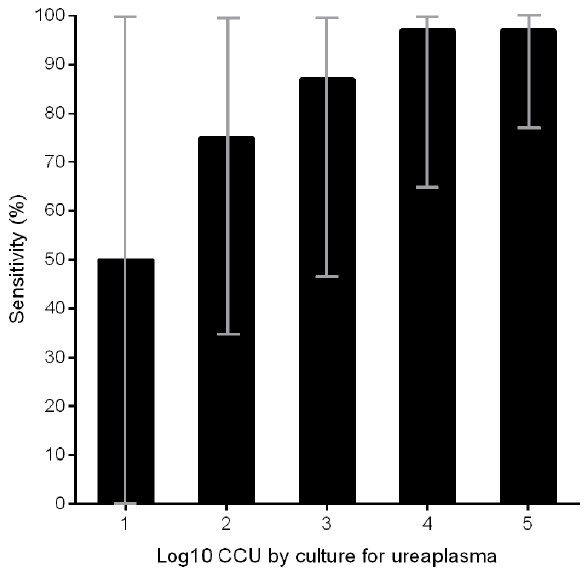
Figure 2. Bar-chart showing sensitivity in CCU group 1–5 for all sample types, male and female samples combined. CCU 1–5: 1 positive of 2 (50%), 9 of 12 (75%), 13 of 15 (87%), 28 of 29 (97%) and 70 of 72 (97%), respectively. Confidence intervals (95%) are depicted as grey vertical lines.